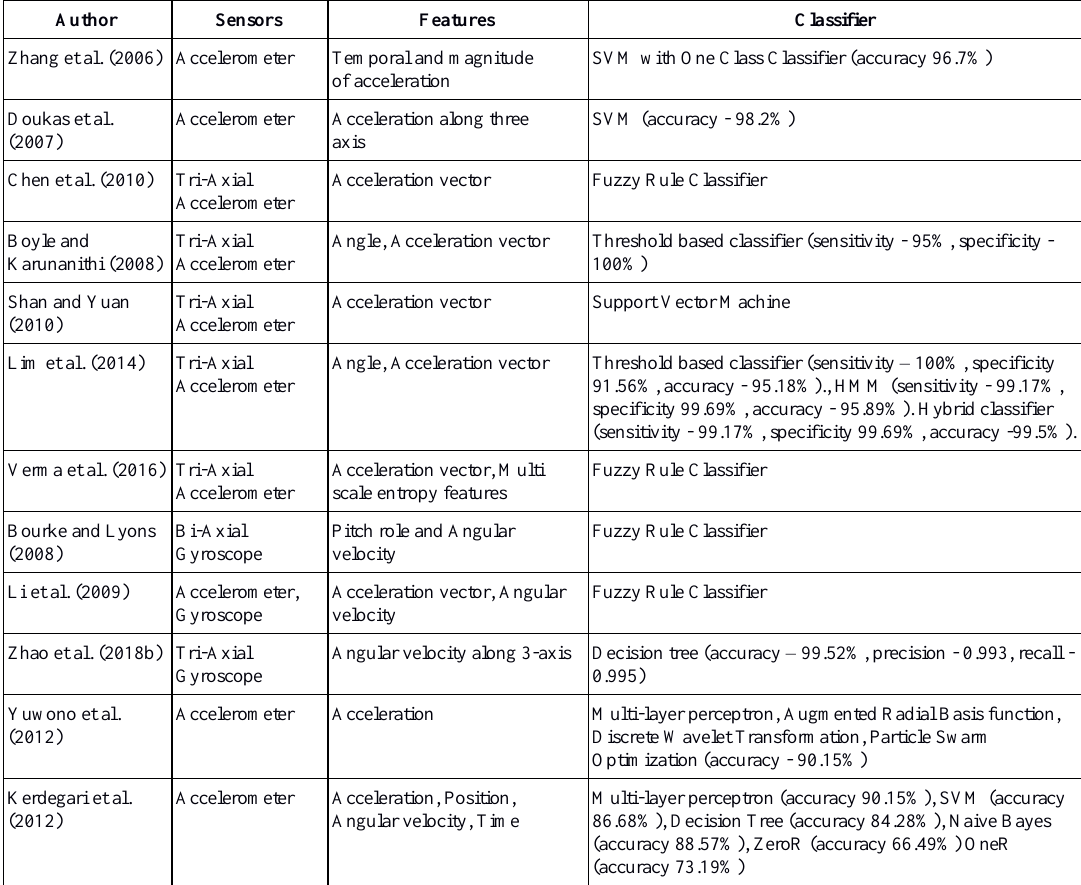
Table 1. Wearable device-based Fall Detection